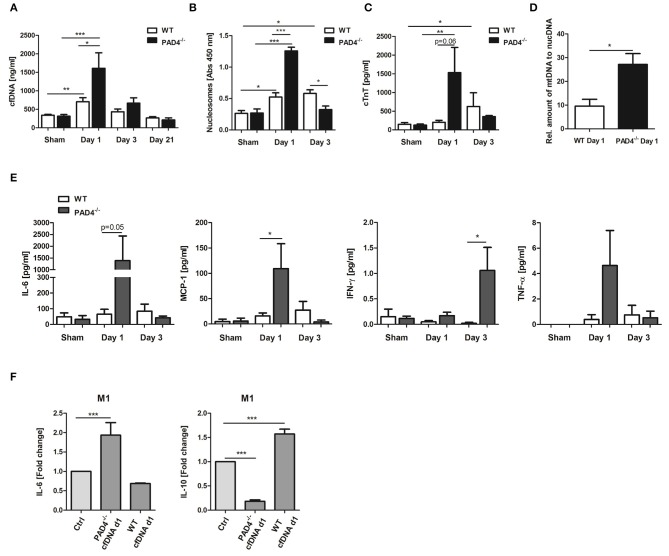
Impact of PAD4-deficiency on the plasma levels of cfDNA, nucleosomes, cardiac troponin and inflammatory markers after MI. cfDNA (A), nucleosomes (B), and cardiac troponin (cTnT) (C) levels were quantified in plasma samples of WT and PAD4−/− mice at day 1, day 3, and day 21 after MI. n = 5–12. *p < 0.05; **p < 0.01; ***p < 0.001. Intra-group differences were determined by two-way ANOVA with Newman-Keuls post-hoc test. For inter-group differences, the Student t-test was used. (D) Relative quantification of plasma mtDNA at day 1 post-MI. n = 5. *p < 0.05 determined by Student t-test. (E) Plasma levels of IL-6, MCP-1, IFN-ɤ, and TNF-α were quantified by ProcartaPlex Multiplex Assay. n = 5–6. *p < 0.05 determined by the Mann-Whitney test. (F) Macrophages (M0) were cultured under M1-polarizing culture conditions and stimulated with cfDNA (600 ng/ml) isolated from plasma of WT and PAD4−/− mice at day 1 post-MI. After 24 h, levels of IL-6, and IL-10 were quantified in culture supernatants by ELISA. Fold change in expression vs. unstimulated control cells is depicted. n = 6. ***p < 0.001 determined by two-way ANOVA followed by Newman-Keuls post-hoc test.